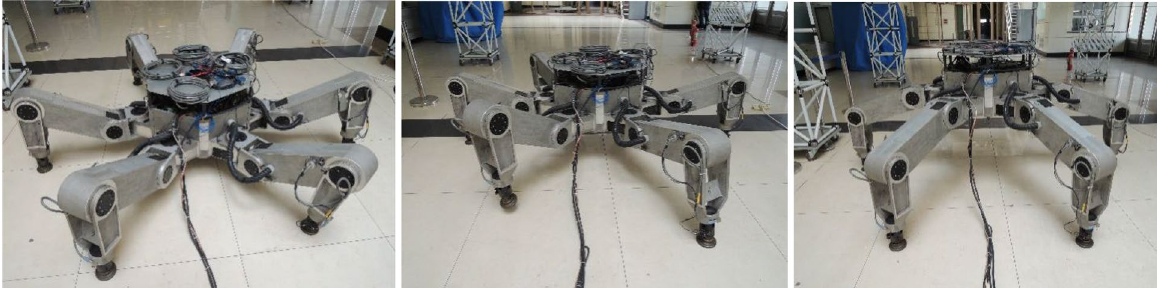
Figure 19 Walking experiments of mixture-type II gait